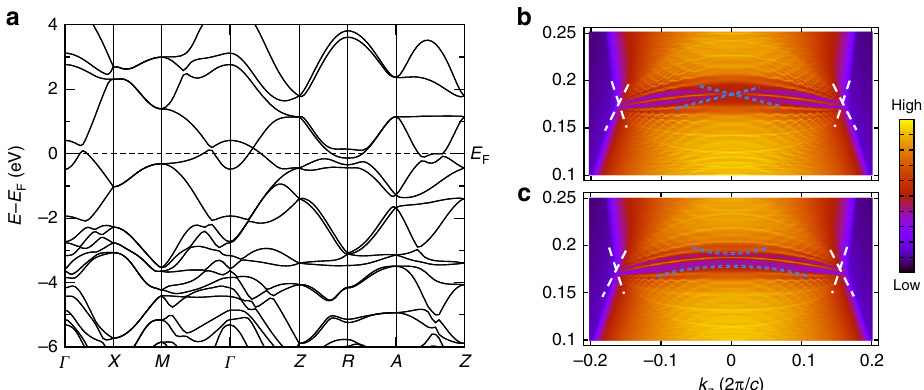
Fig. 5 HOFA states and fragile Dirac semimetal phase in β ′ -PtO 2 . a Bulk bands incorporating the effects of SOC of the candidate Dirac semimetal β ′ -PtO 2 in SG 136 ( P 4 2 = mnm 1 0 ) 60,61 . Unlike in the Dirac semimetals α ″ -Cd 3 As 2 and KMgBi examined in Fig. 4, the k z = 0 plane of β ′ -PtO 2 is equivalent to a 2D TCI ¼ 2 (ref. 61 and Supplementary Note 13). b The hinge spectrum of β ′ -PtO with mirror Chern number C M 2 exhibits two narrowly split HOFA states z connecting the hinge projections of the bulk 3D Dirac points (white) to the projections of two surface TCI cones at k z = 0 (blue). Fixing the system fi lling to that of the bulk Dirac points, we fi nd that the lower HOFA state in energy in ( b ) is half- fi lled, and therefore exhibits a topological quadrupole moment, and the higher state is unoccupied, and is thus topologically trivial, as discussed in Supplementary Notes 9 and 13. c In the presence of a z -directed external electric fi eld, the surface TCI cones in β ′ -PtO 2 become gapped (blue), allowing for the two HOFA states to meet at k z = 0 in a quarter- fi lled Kramers pair of corner modes that is characteristic of the fragile phase introduced in this work (Figs. 2i – k, 3e, h, and Supplementary Notes 4, 9, and 13). The bulk band structure in ( a ) was obtained from fi rst-principles, and then used to fi t a tight-binding model whose hinge Green's functions in the absence and presence of an external electric fi eld are shown in ( b ) and ( c ), respectively (Supplementary Note